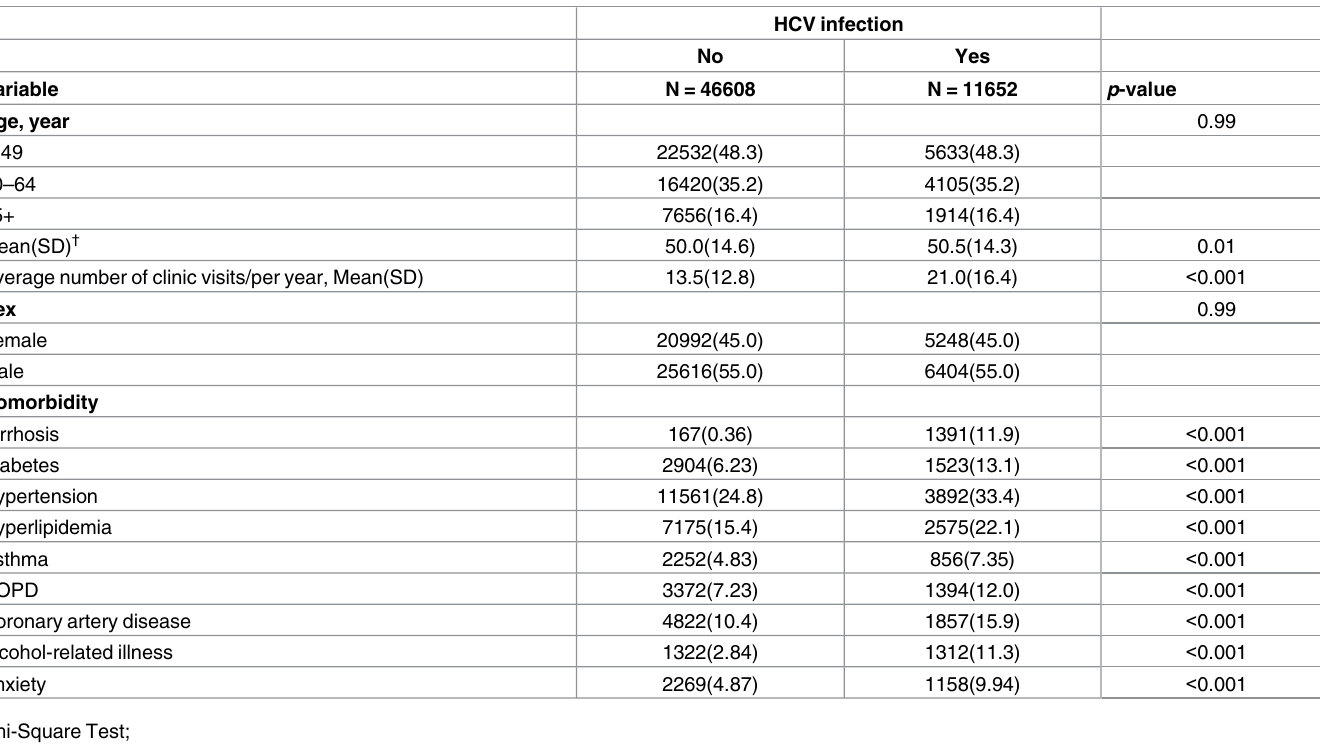
Table 1. Demographic characteristics and comorbidities in cohorts with and without HCV infection.